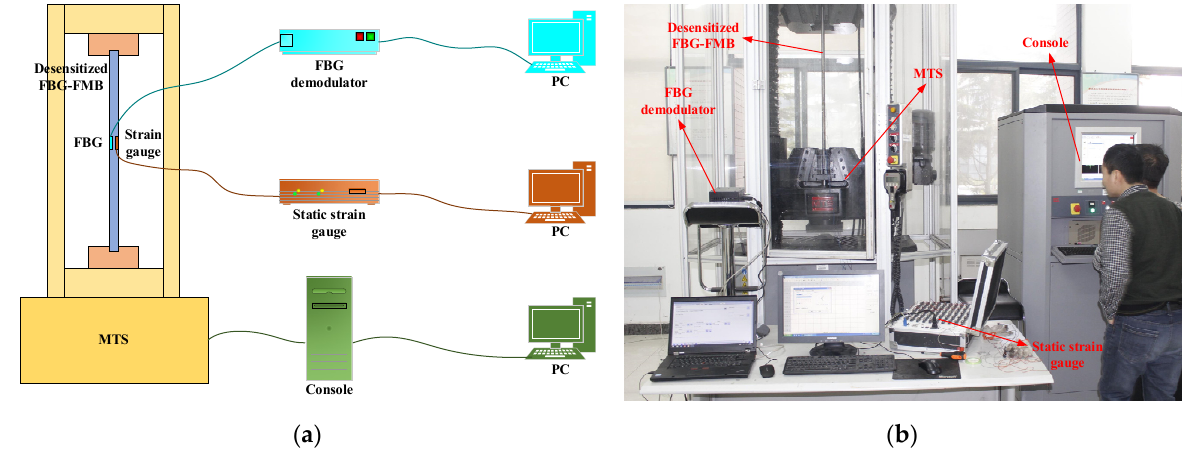
Figure 9. Experimental system principle picture and photo. ( a ) Experimental schematic diagram; ( b ) photo of experimental system.